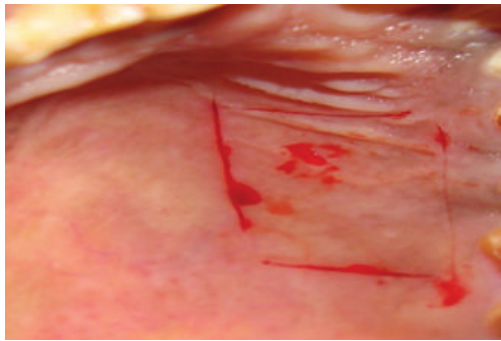
Figure 9: Graft placement under the flap.